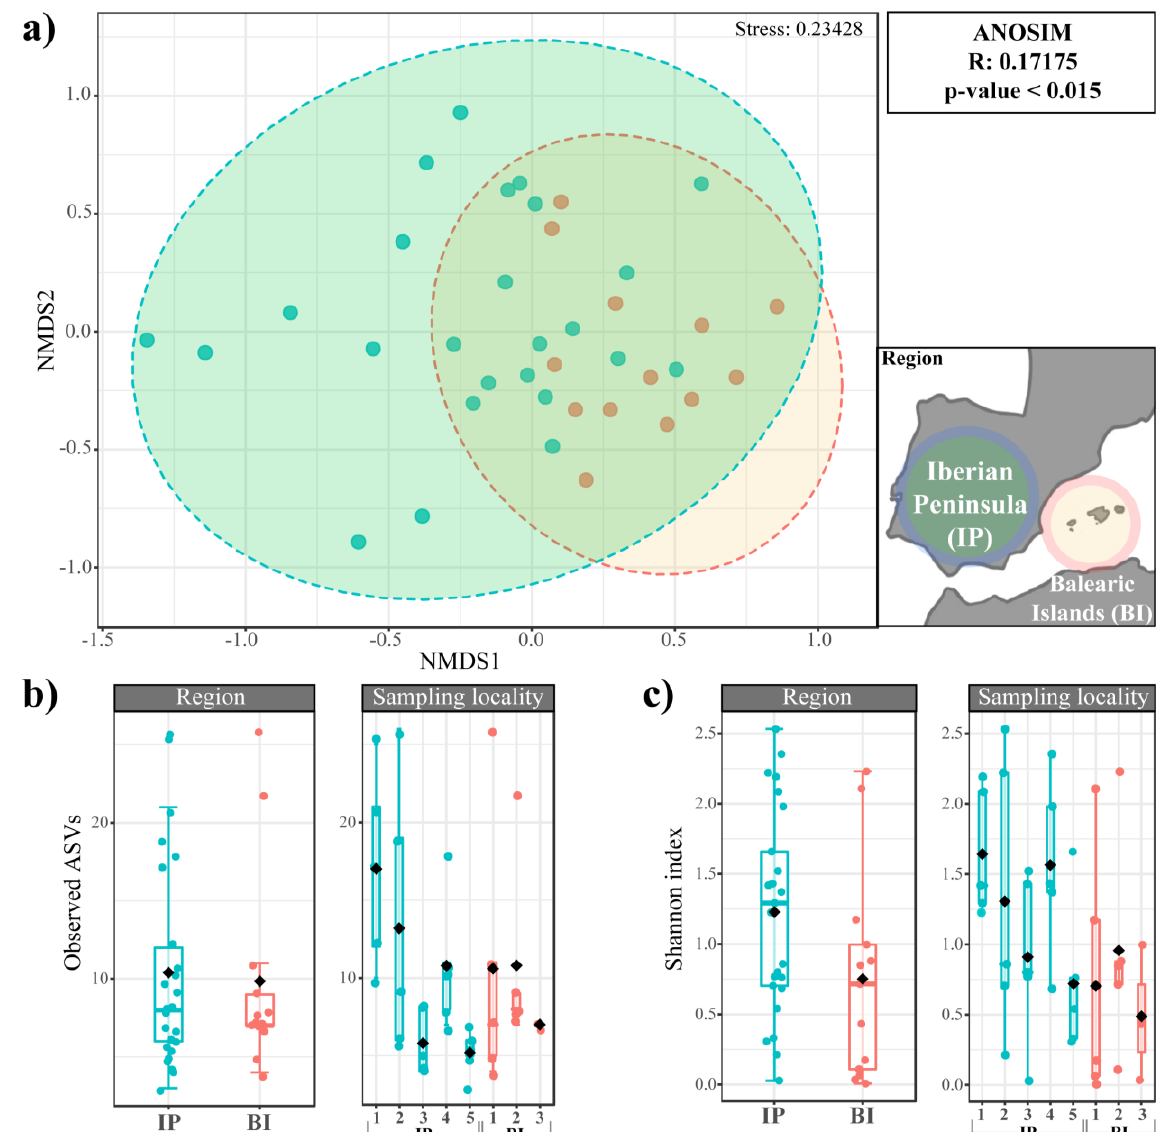
Figure 3. ( a ) Non-metric multidimensional scaling (NMDS) ordination plot of Bray–Curtis dissimilarities for Trebouxia microalgae present in thalli of Buellia zoharyi from the Iberian Peninsula (blue-green) and the Balearic Islands (light orange); inset at the upper right-hand corner indicates statistical support for β -diversity differences provided by the ANOSIM test. Boxplots in ( b , c ) represent two alpha-diversity estimators (observed ASVs and Shannon index, respectively) for phycobiont communities arranged according to the two main regions (IP, Iberian Peninsula; BI, Balearic Islands) and sampling localities within (see numerical codes in Table